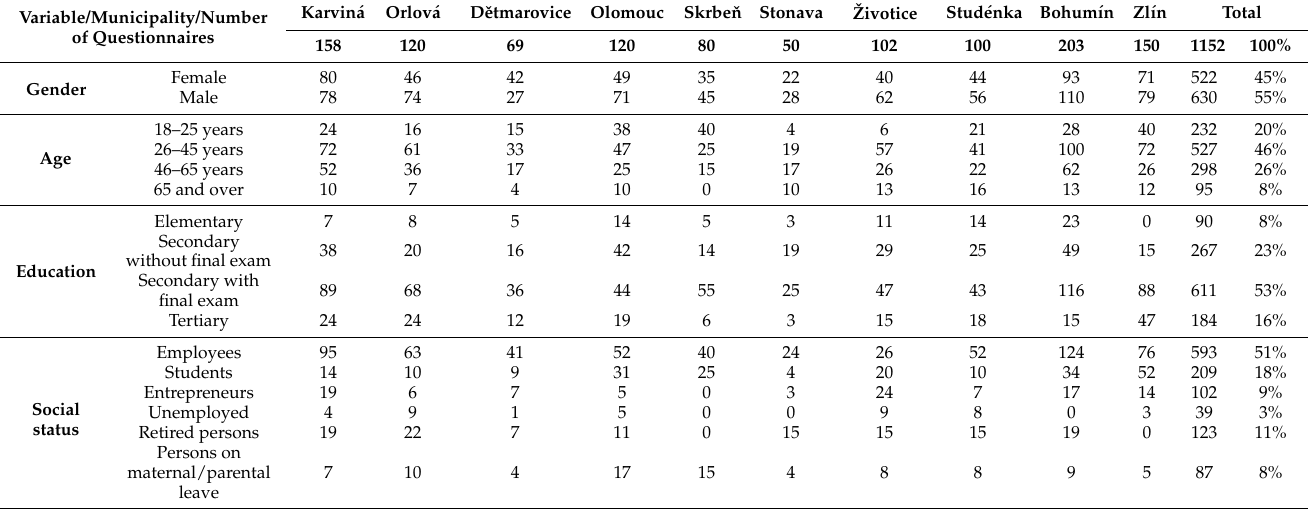
Table 1. Basic segmentation of respondents from surveys in 10